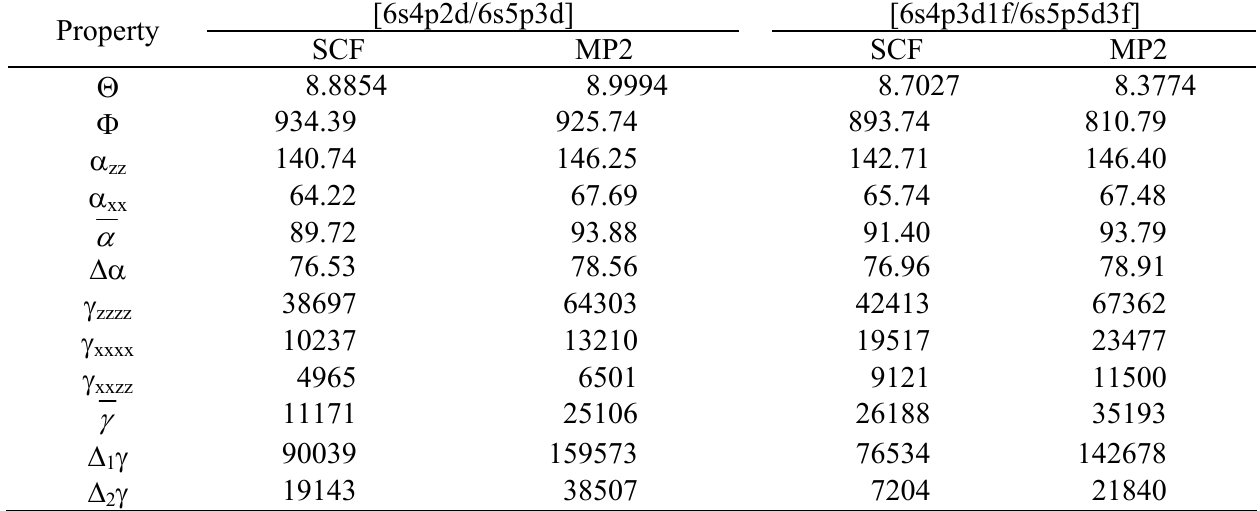
Table 4. Electric properties of ICCI a